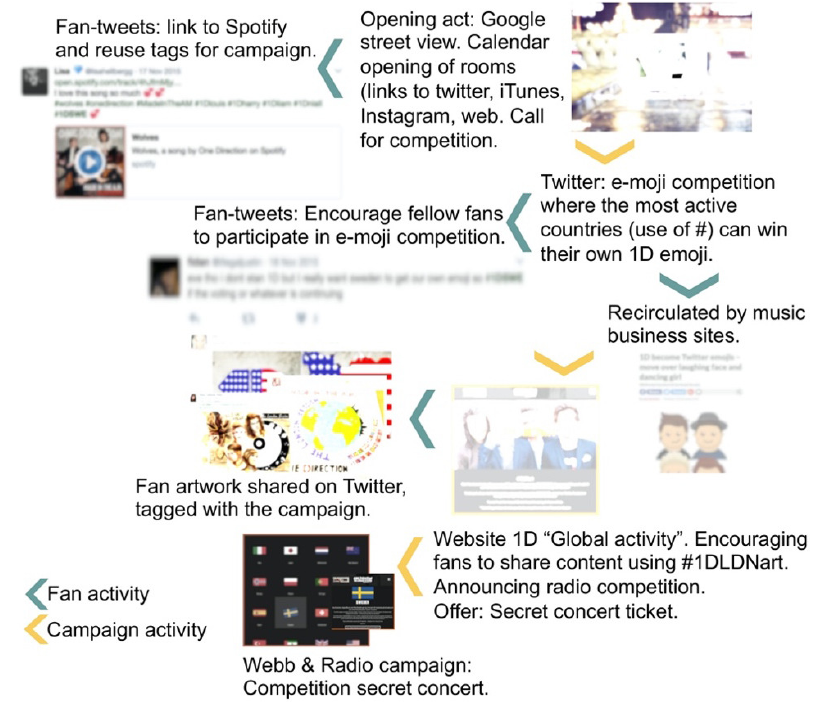
Figure 1. An example of a visual map for the One Direction marketing